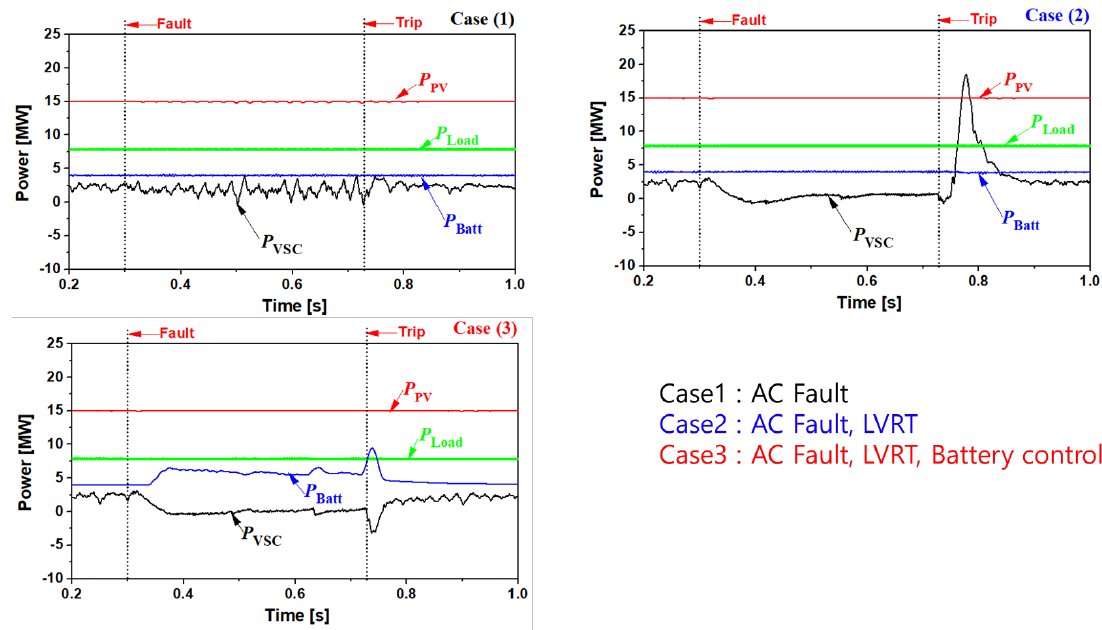
Figure 12. Power Waveform of PV (Photovoltaic), DC Load, Battery and VSC (Voltage Sourced Converter) in Case (1)-(3).